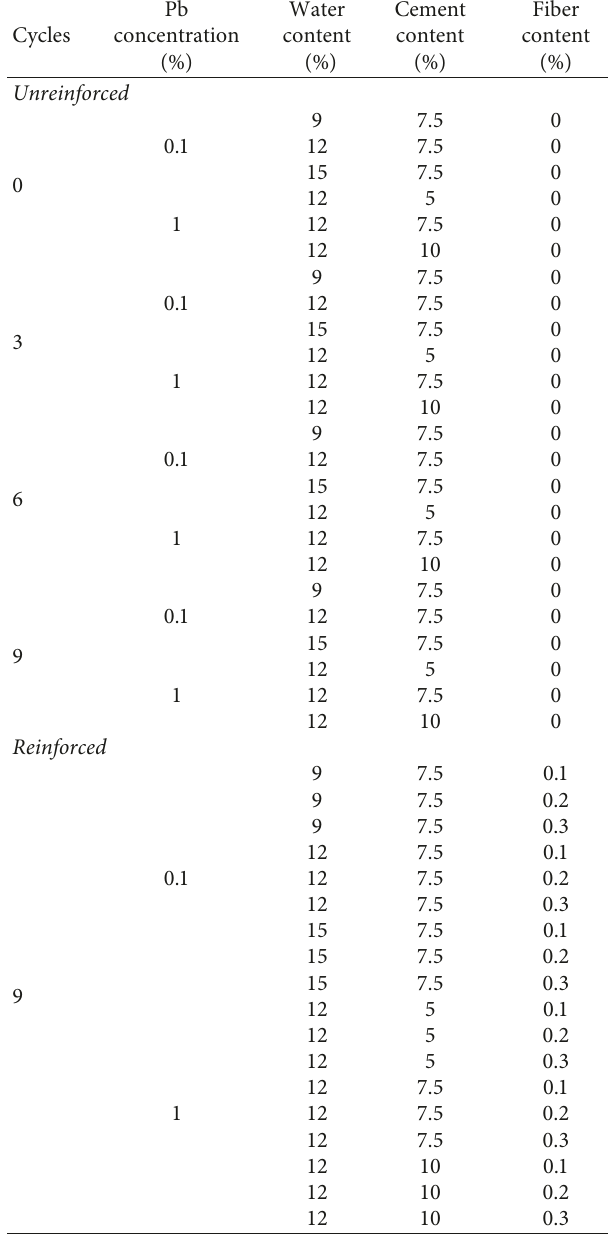
Table 2: Composition and properties of the soil mixtures. Pb Cycles